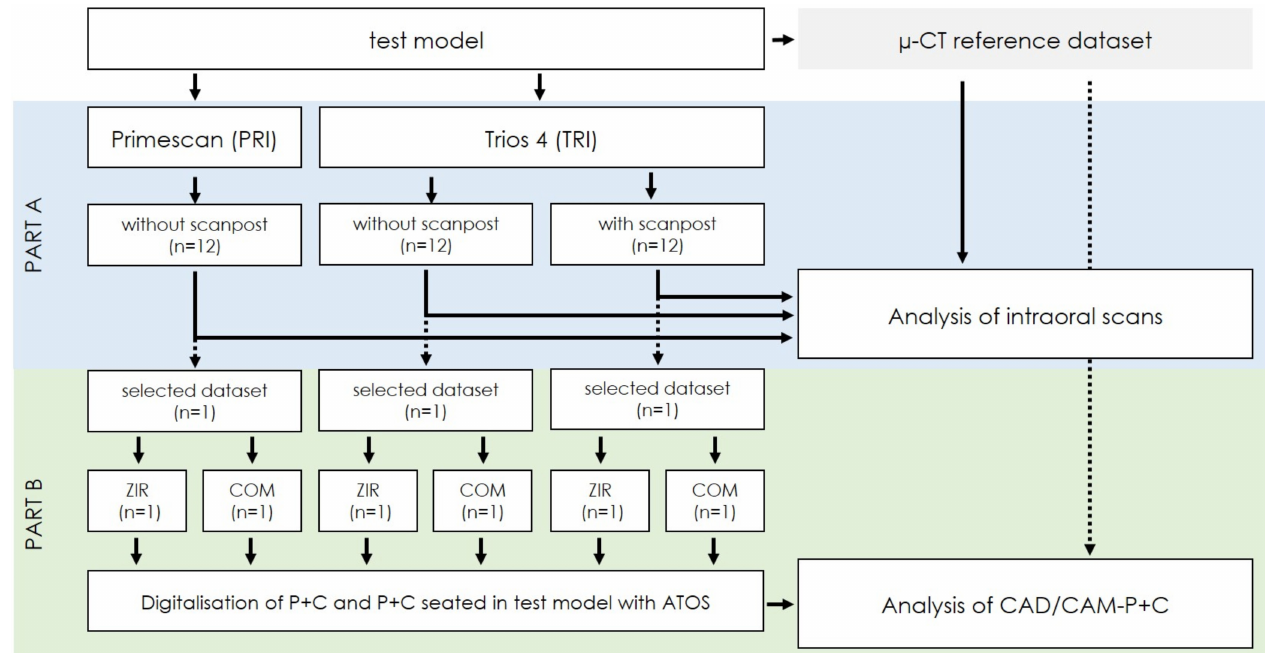
Figure 1. Flow scheme of the investigation; procedure was conducted for each of the five test